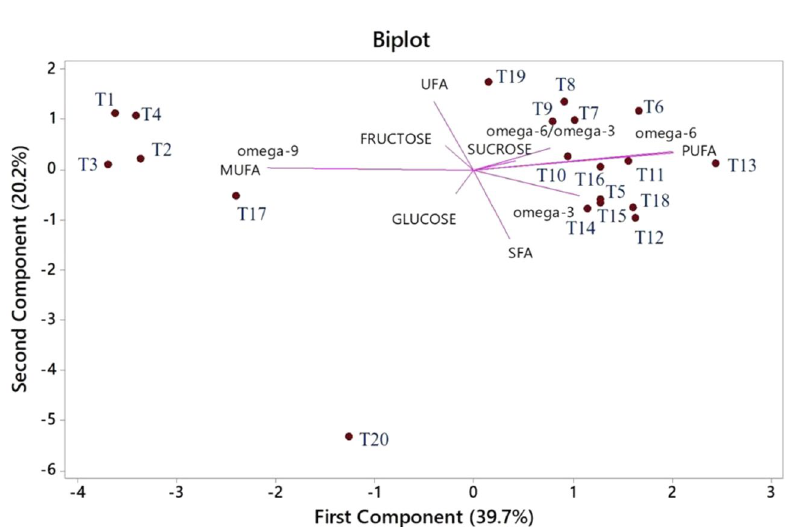
Figure 5. Omega (3 and 6) fatty acid biosynthesis pathways [Adapted from 60,61 with modifications]. This figure is created by Microsoft PowerPoint software (Version 2016; Microsoft Corporation. Retrieved from https:// www. micro soft. com/ en- us/ micro soft- 365/ power point).